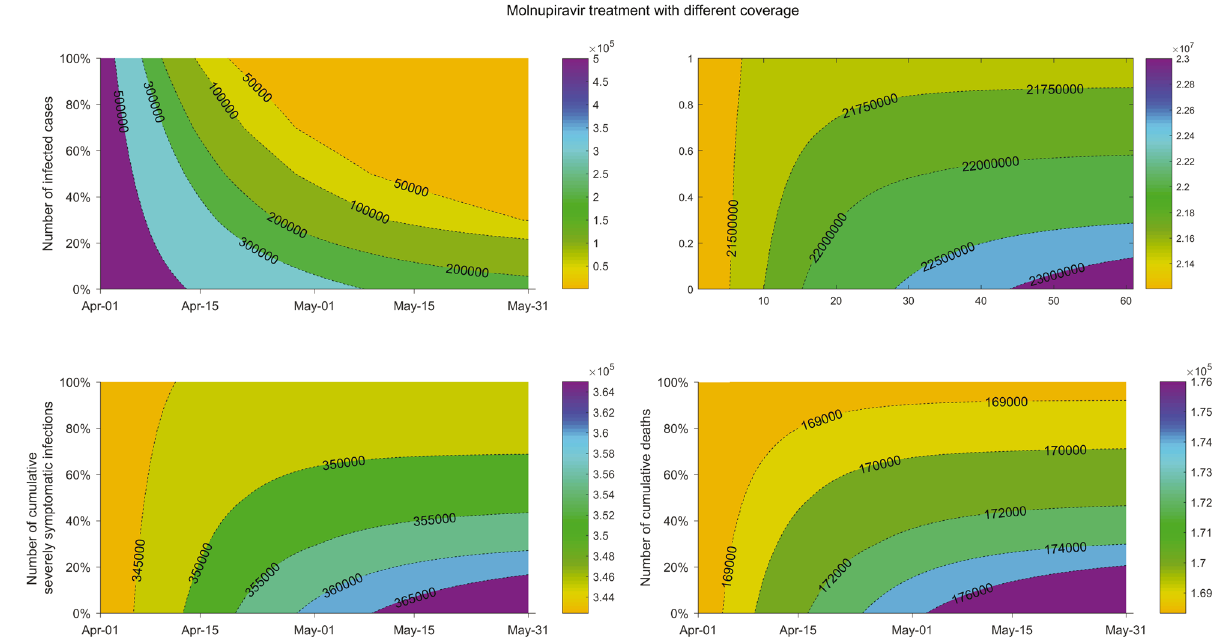
Figure 6. The impact of different coverages of molnupiravir treatment in the setting of UK. In this scenario, nonhospitalized cases including latent ones, asymptomatic cases, and symptomatic patients would be proportionally treated with molnupiravir. The settings of social activity level, the reinfection proportion, dominating pango lineages, and the molnupiravir treatment effectiveness for individuals are identical to those in Fig. 4. Contours represent epidemic performance under different coverage and time.